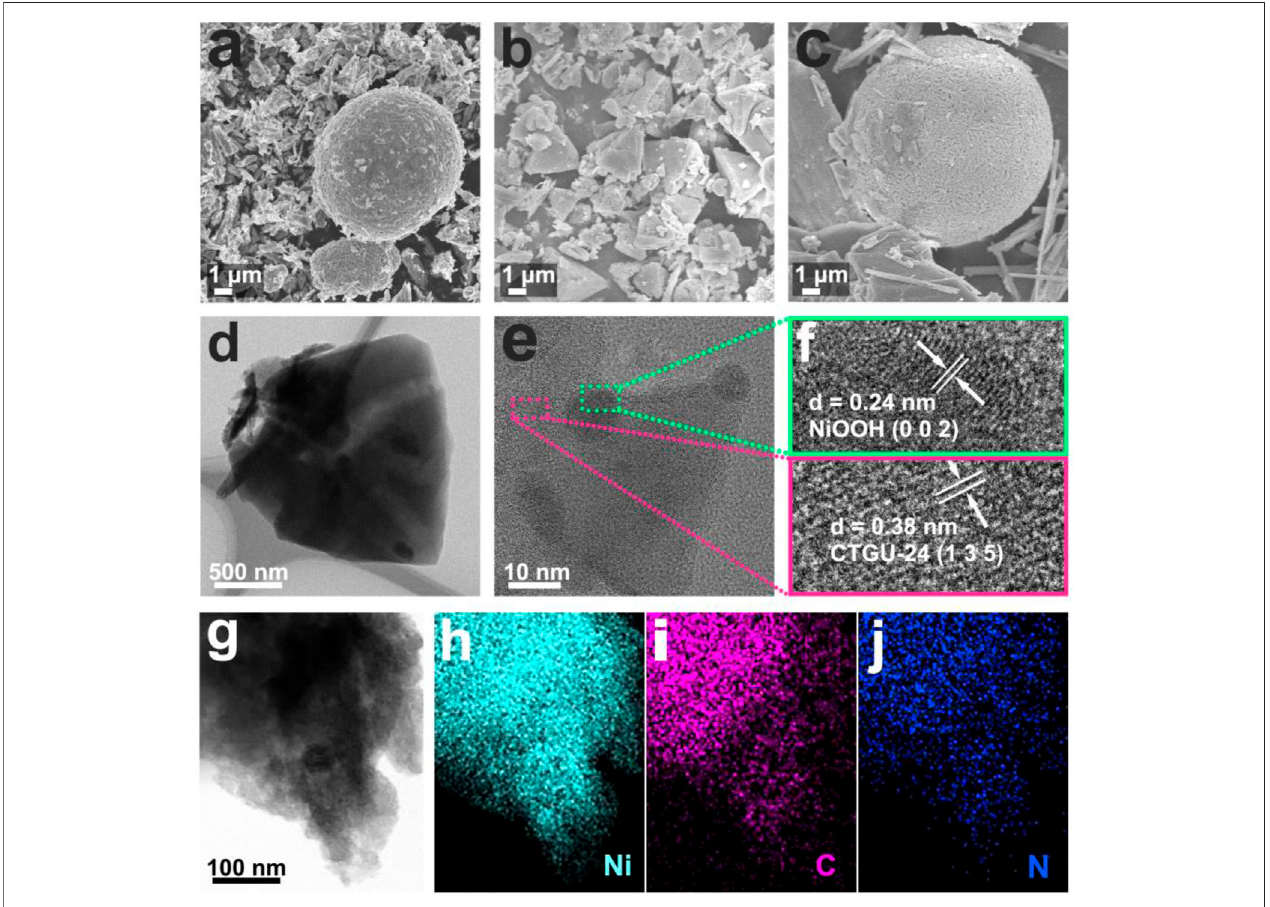
FIGURE3 | Morphology and structure characterizations ofNiOOH, CTGU-24 and CTGU-24@NiOOH. (A) SEM image of NiOOH. (B) SEMimage ofCTGU-24. (C) SEM image of CTGU-24@NiOOH. (D, G) HRTEM image of CTGU-24@NiOOH, and STEM-EDX elemental mapping of CTGU-24@NiOOH for (H) Ni, (I) C, and (J) N